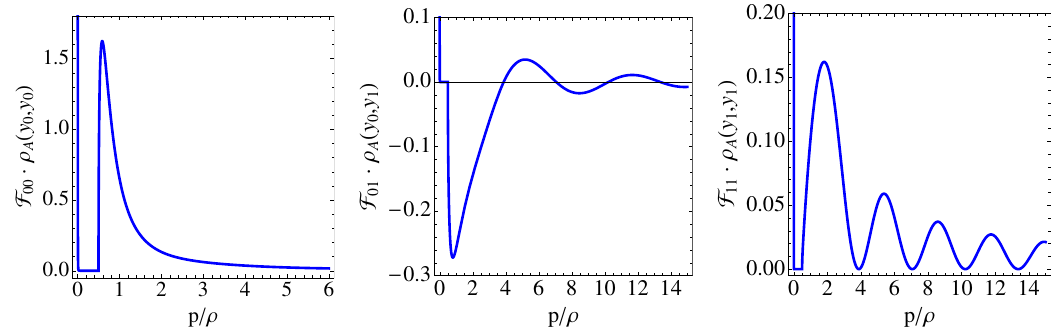
Figure 7 . Rescaled spectral functions F 00 · ρ A ( y 0 , y 0 ; p ) (left panel), F 01 · ρ A ( y 0 , y 1 ; p ) (middle panel) and F 11 · ρ A ( y 1 , y 1 ; p ) (right panel) as a function of p/ρ , for a continuum gauge boson. We have used A 1 = 35 in all panels and assume time-like momenta p 2 > 0